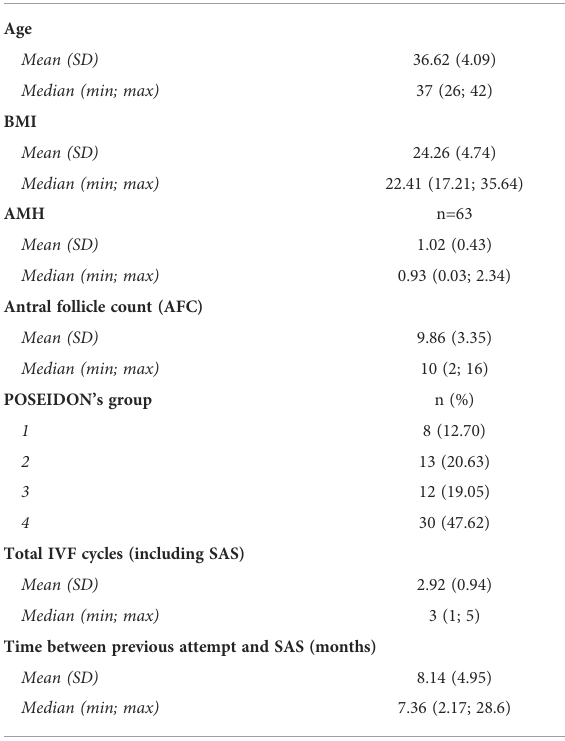
TABLE 1 Demographic and baseline characteristics at the beginning of SAS